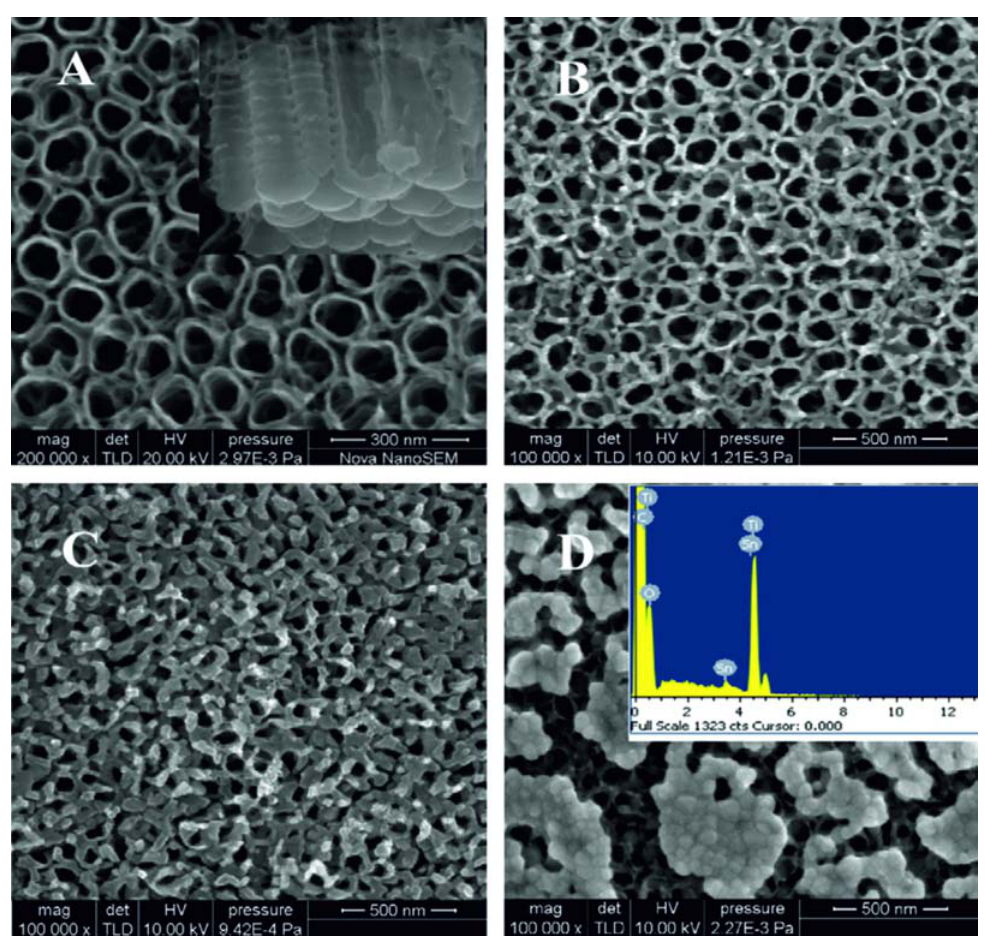
NTs, ( B ) ST3, ( C ) ST5 and ( D ) ST7 (inset is 2